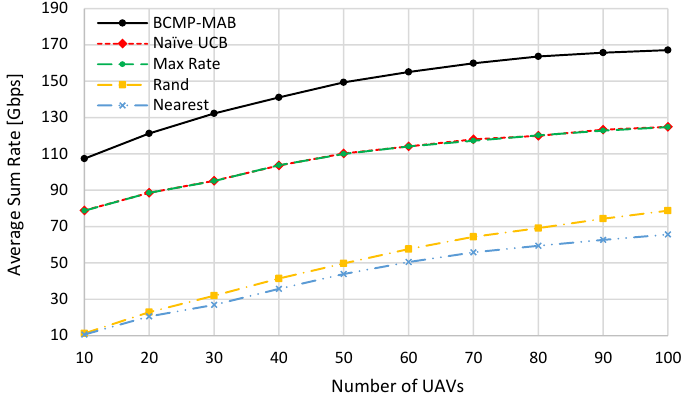
Figure 5. Average sum rate against number of UAVs.